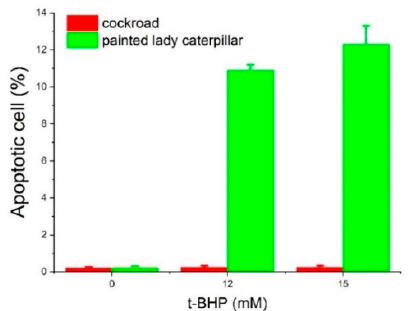
Figure 6. The fraction of apoptotic cells from painted lady caterpillars and cockroaches.